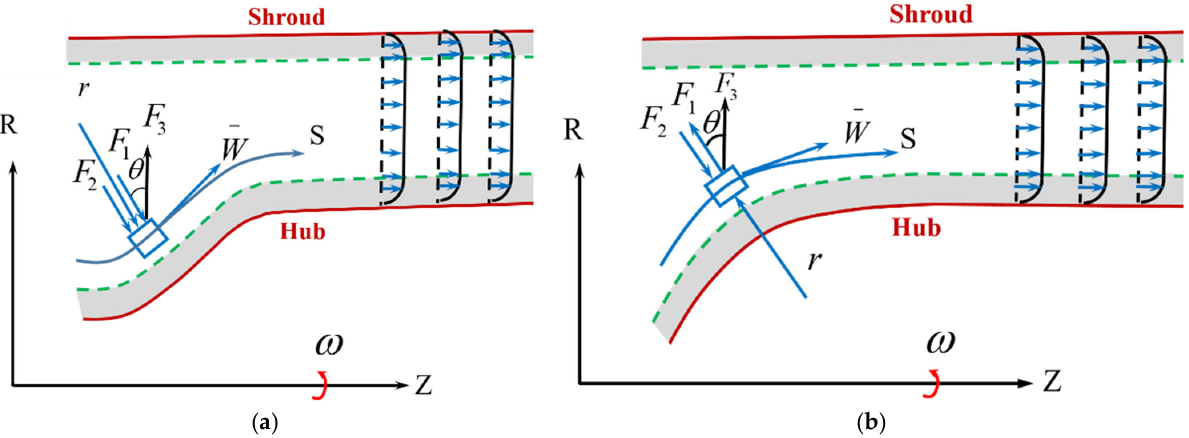
Figure 6. The forces of the fluid particle in concave and convex hub profiles. ( a ) concave hub; ( b ) Convex hub.